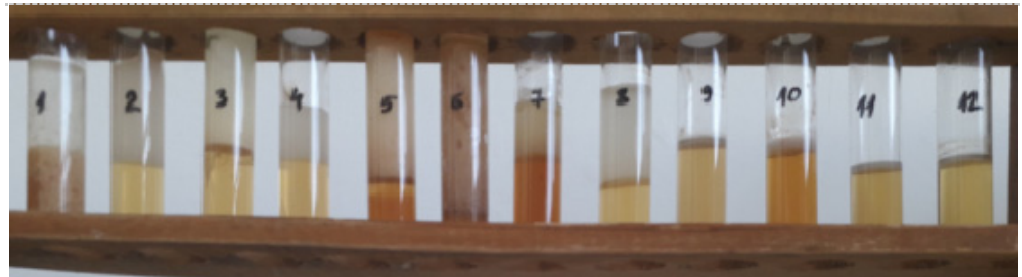
Figure 9. Emulsions obtained with the supernatants of the two strains cultivated on LB and KB media: supernatants of P. putida with: sunflower oil 1 and 2, heptane 3 and 4, octane 5 and 6; supernatants of B. mycoides with sunflower oil 7 and 8, heptane 9 and 10, octane 11 and 12.